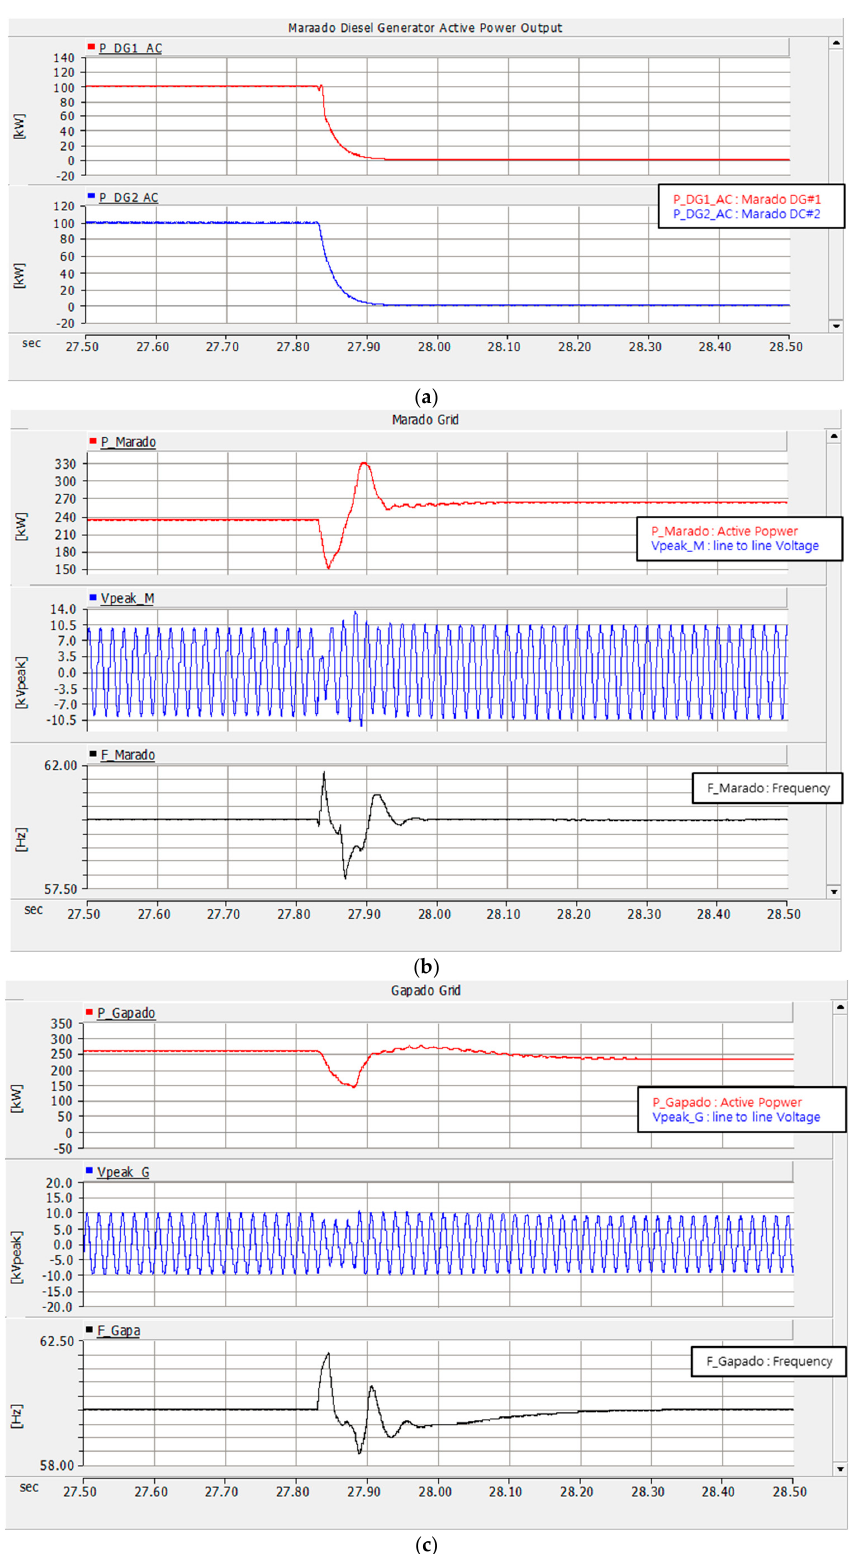
Figure 16. ( a ) Active power output of diesel generator; ( b ) Variation of Marado Island power grid; ( c ) Variation of Gapado Island power grid; through the Marado Island diesel fault [17–21].